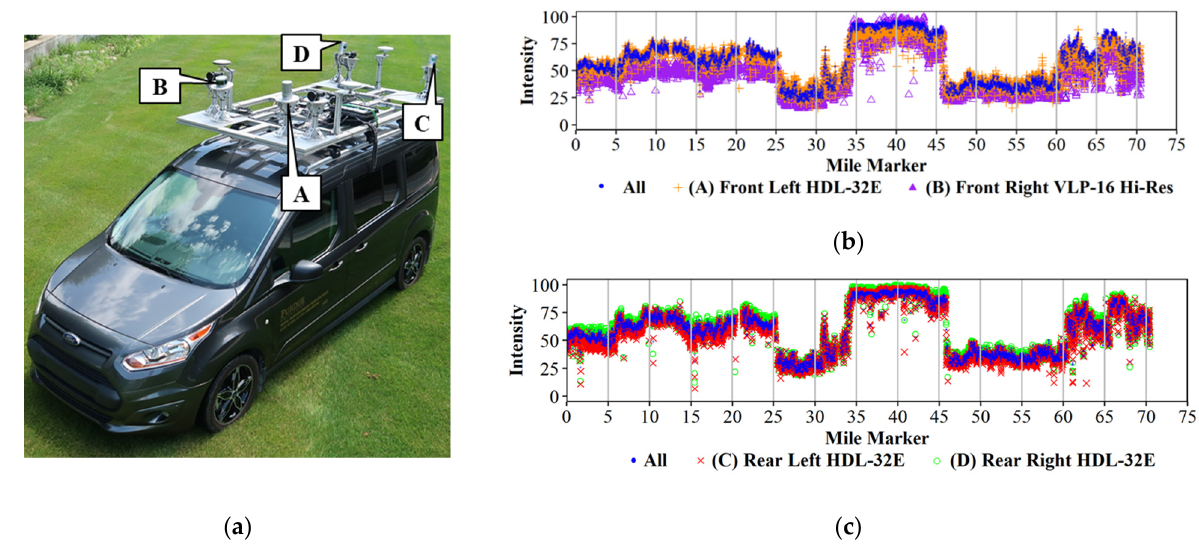
Figure 14. Purdue mobile mapping system sensor comparison: ( a ) sensor location; ( b ) front sensors comparison; ( c ) rear